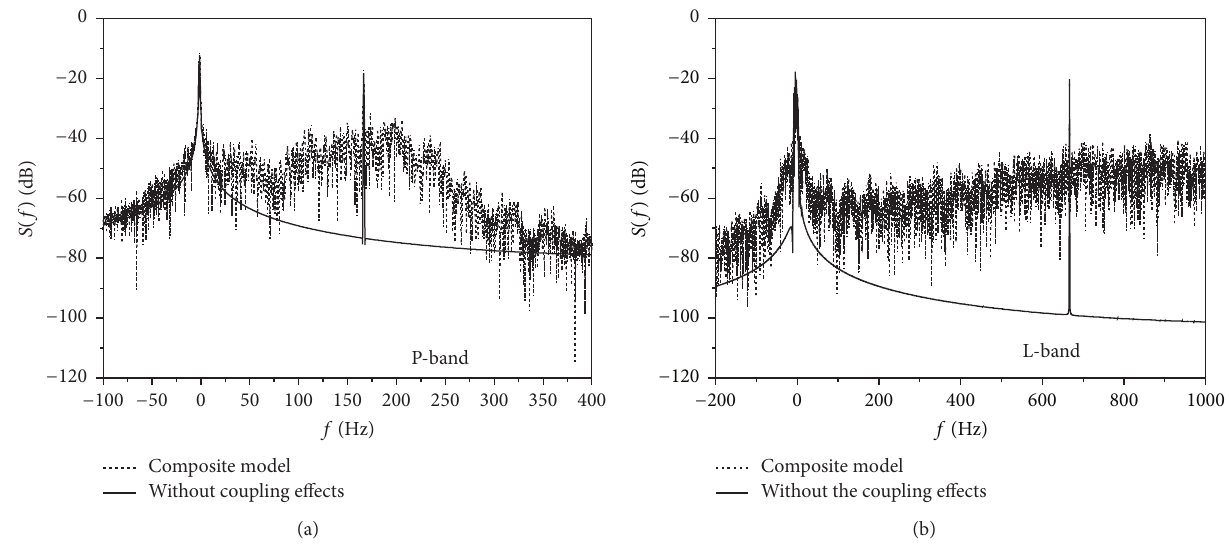
Figure 10: The coupling effects on the Doppler spectrum of the composite model. (a) P-band, (b)